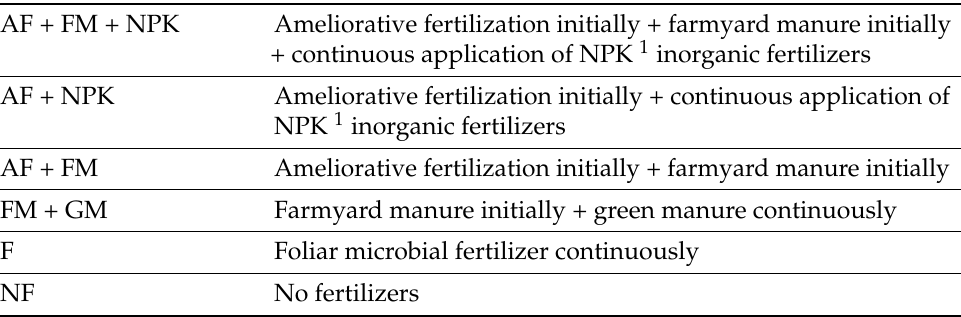
Table 2. The fertilization strategies in the observed